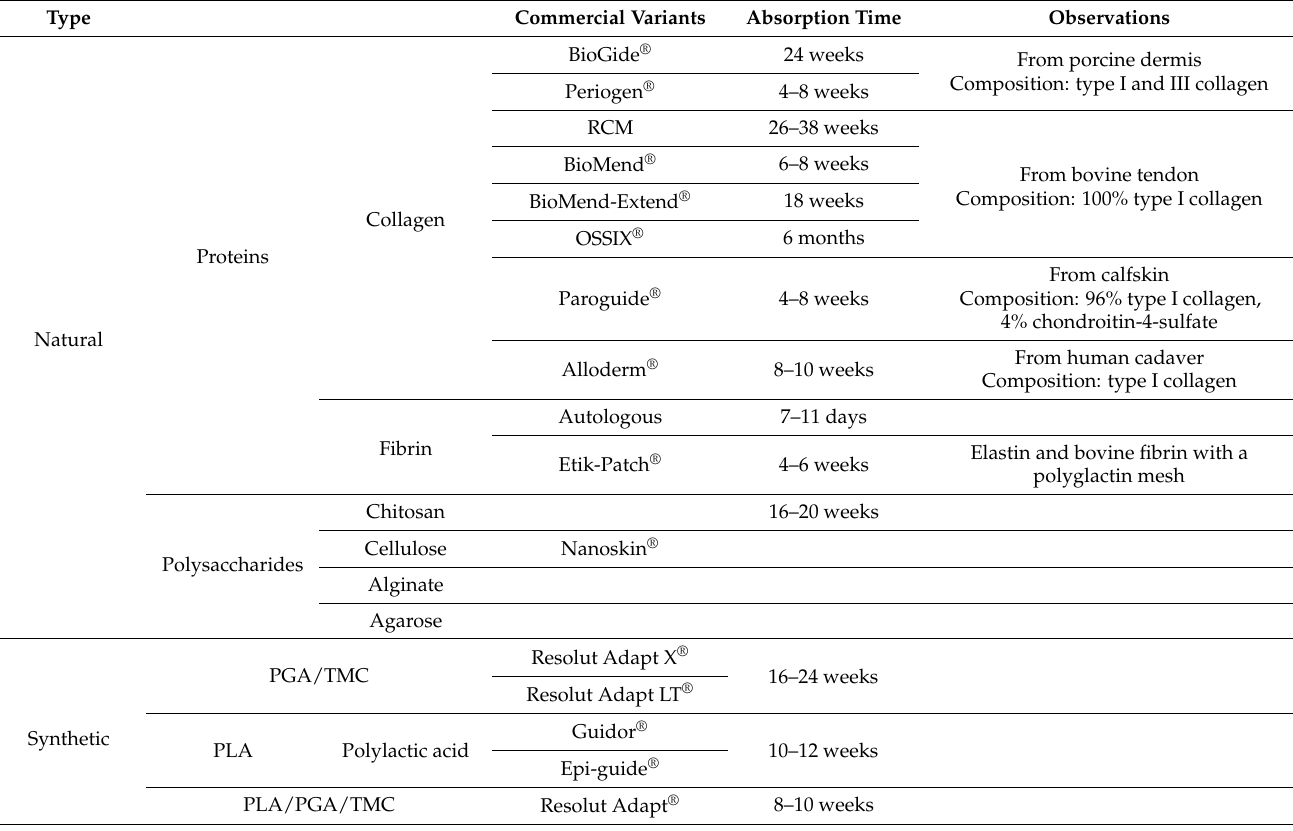
Table 2. Types of absorbable barrier